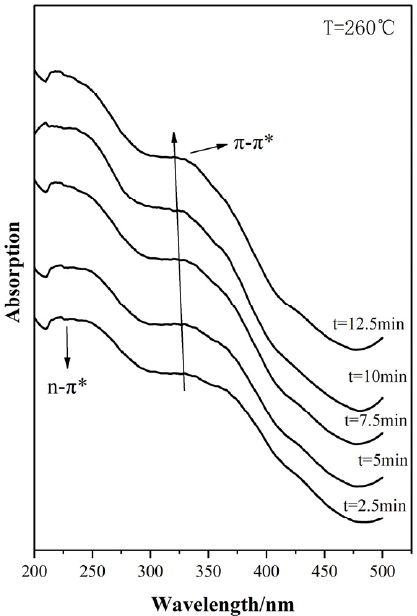
Figure 9. UV-vis absorption spectra of stabilized PAN fibers with different treatment times.